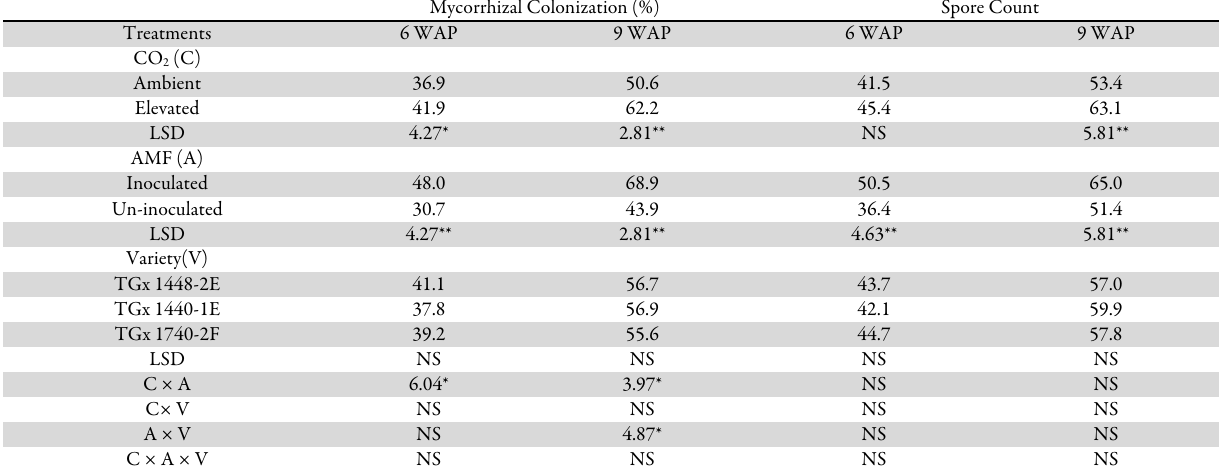
Table 3. Effect of CO 2 enrichment and AMF inoculation on percentage mycorrhizal colonization and AMF sporulation of soybean variety at 6 and 9 WAP (Pot experiment)